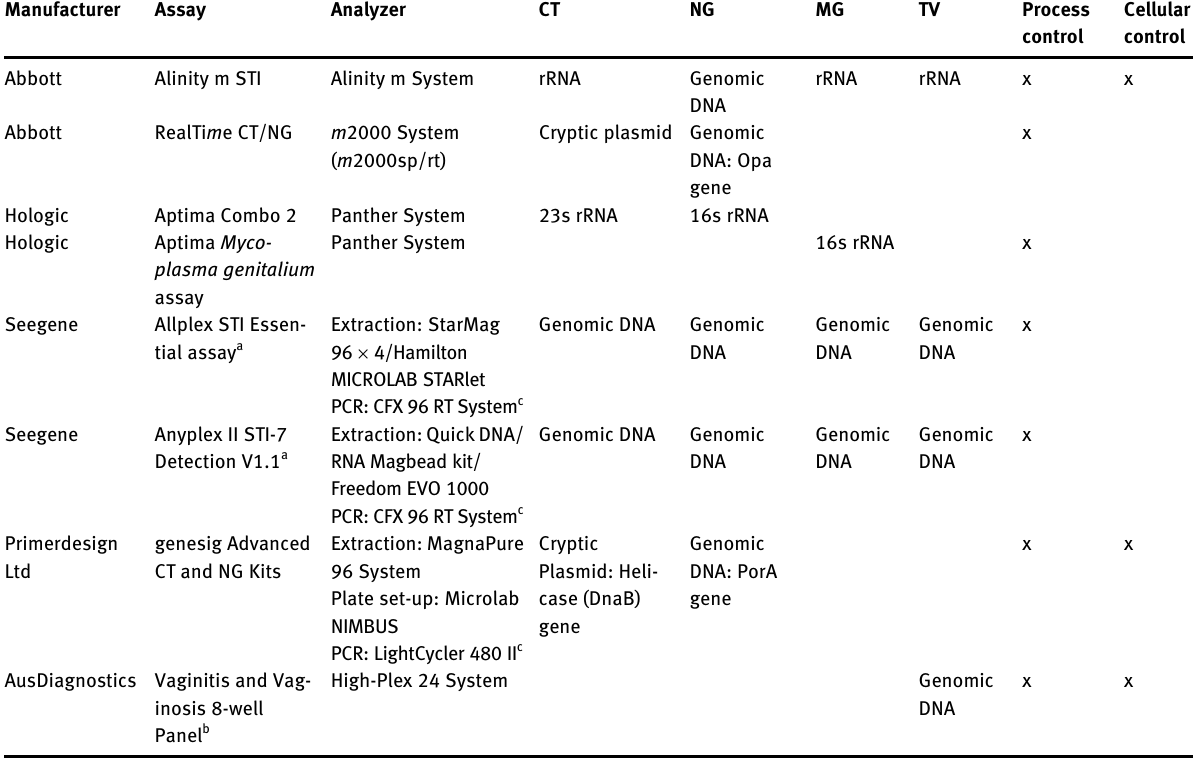
Table  : STI assay platforms compared in the